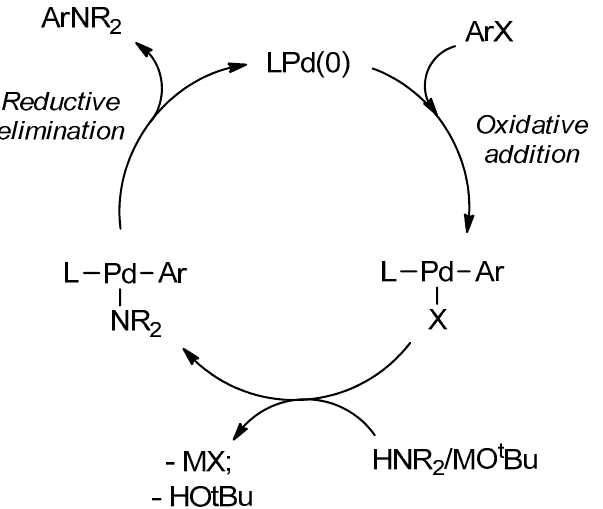
Figure 2. Simpli fi ed catalytic cycle for Buchwald − Hartwig amination reaction. Figure 2. Simplified catalytic cycle for Buchwald − Hartwig amination reaction.